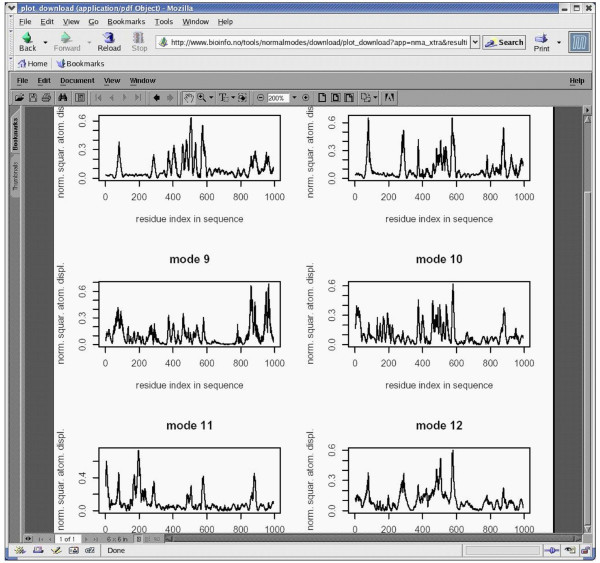
Normalized atomic displacements plots. Plots for modes 7 to 12 are generated on the same page and converted to a PDF file.